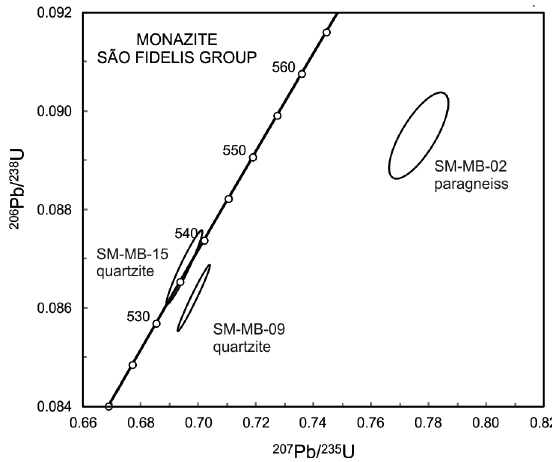
Figure 5 - Concordia diagram for monazites from São Fidelis Group samples. Grain SM-MB-15 is concordant at 535.3 ± 2.4